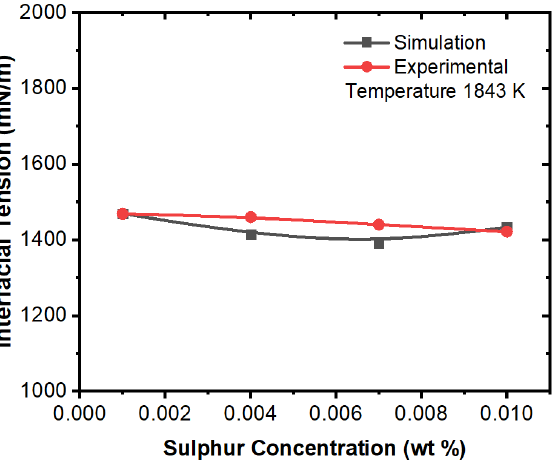
Figure 19. Comparison of experimental and simulation results of interfacial tension with respect to sulfur concentration (temperature 1843 K, experimental work by Jeong et al. [26]).